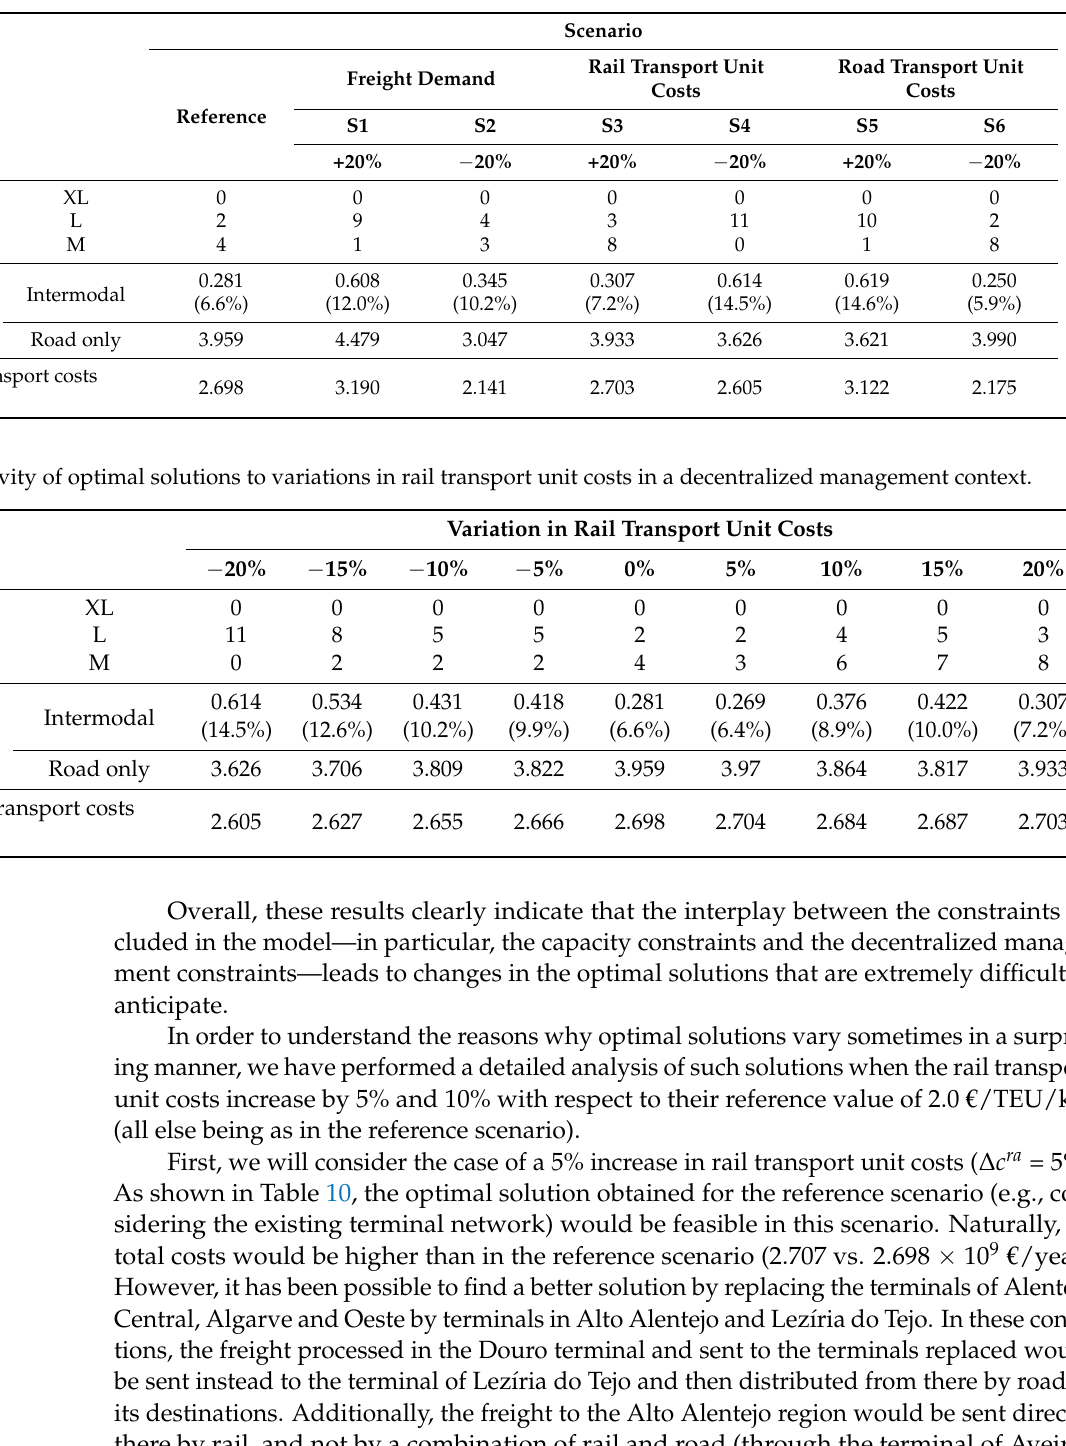
Table 8. Sensitivity of optimal solutions to variations in freight demand and transport costs in a decentralized management context.